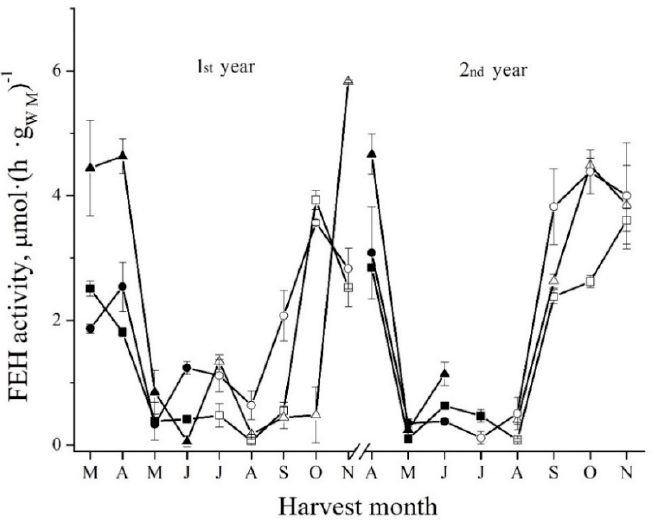
Figure 1. Seasonal fluctuations of FEH activity in the tubers of Sauliai ( ● , ○ ), Albik ( ▲ , ∆ ) and Rubik ( ■ , □ ); spring tubers: ● , ▲ , ■ ; summer and autumn tubers: ○ , ∆ , □ .